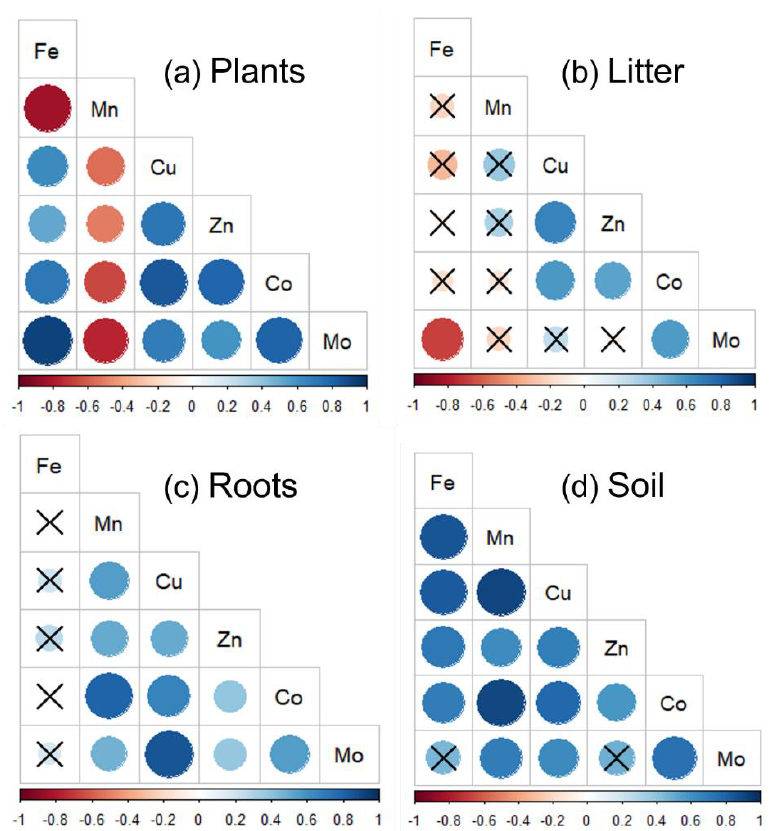
Figure 6. Pearson correlations among six micronutrients (Fe, Mn, Cu, Zn, Co, and Mo) in aboveground plants ( a ), litter ( b ), roots ( c ) and soil ( d ). Red circles indicate positive correlations, whereas bule circles indicate negative correlations, and the symbol × indicates insignificant